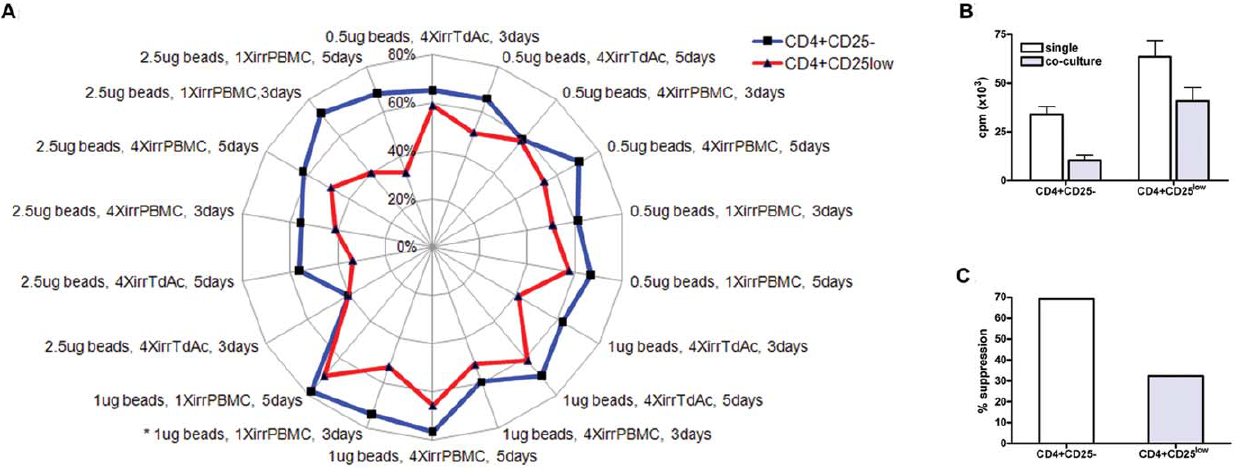
Figure 3. CD4 + CD25 low T cells were suppressed less than CD4 + CD25- in invitro co-culture with Tregs. A) The percentage of suppression for CD4 + CD25- (blue, outer line) and CD4 + CD25 low T cells (red, inner line) as responders in co-culture with Treg (Tresponder:Treg = 1:1) for 3 or 5 days with 18 different combinations of stimuli. The suppression difference is most statistically significant when the type of responder T cells differ (p , 0.003, n=6) irrespective of type of APC or duration and strength of stimuli. Asterisk (*) indicates conditions chosen for experiments that followed. B) Presented are cpm and standard errors for conditions with asterisk in Figure 3A. C) Percentages of suppression for conditions shown with asterix in Figure 3A are presented.